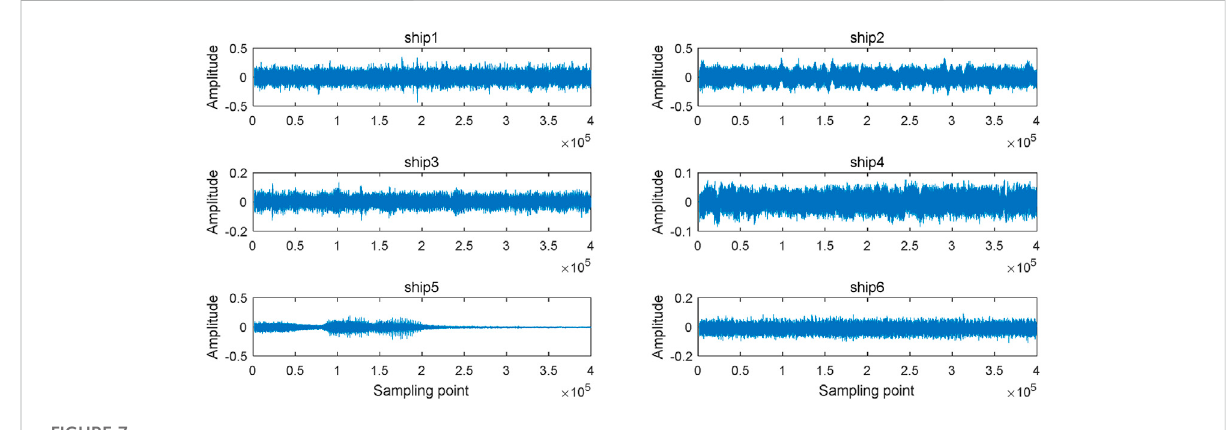
FIGURE 7 Time domain waveform of six SRNs.